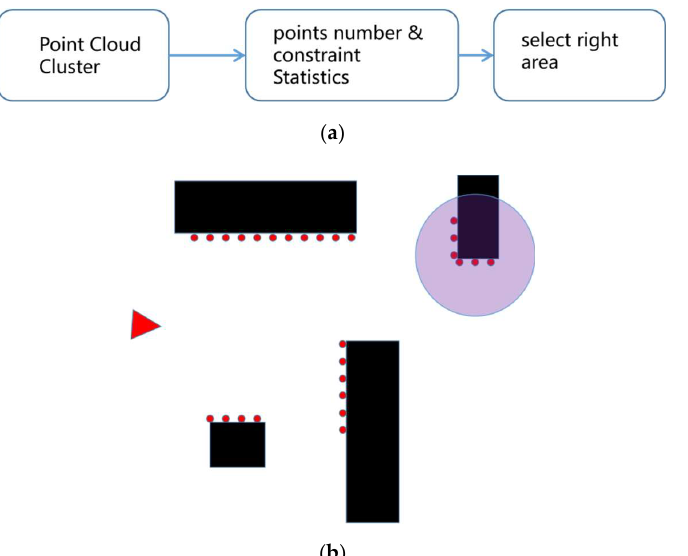
Figure 2. Selection of the attention area in the reference frame. ( a ) Flow diagram; ( b ) schematic diagram. The red triangle is the robot, the red dots are the lidar data, and the purple circle is the attention area.